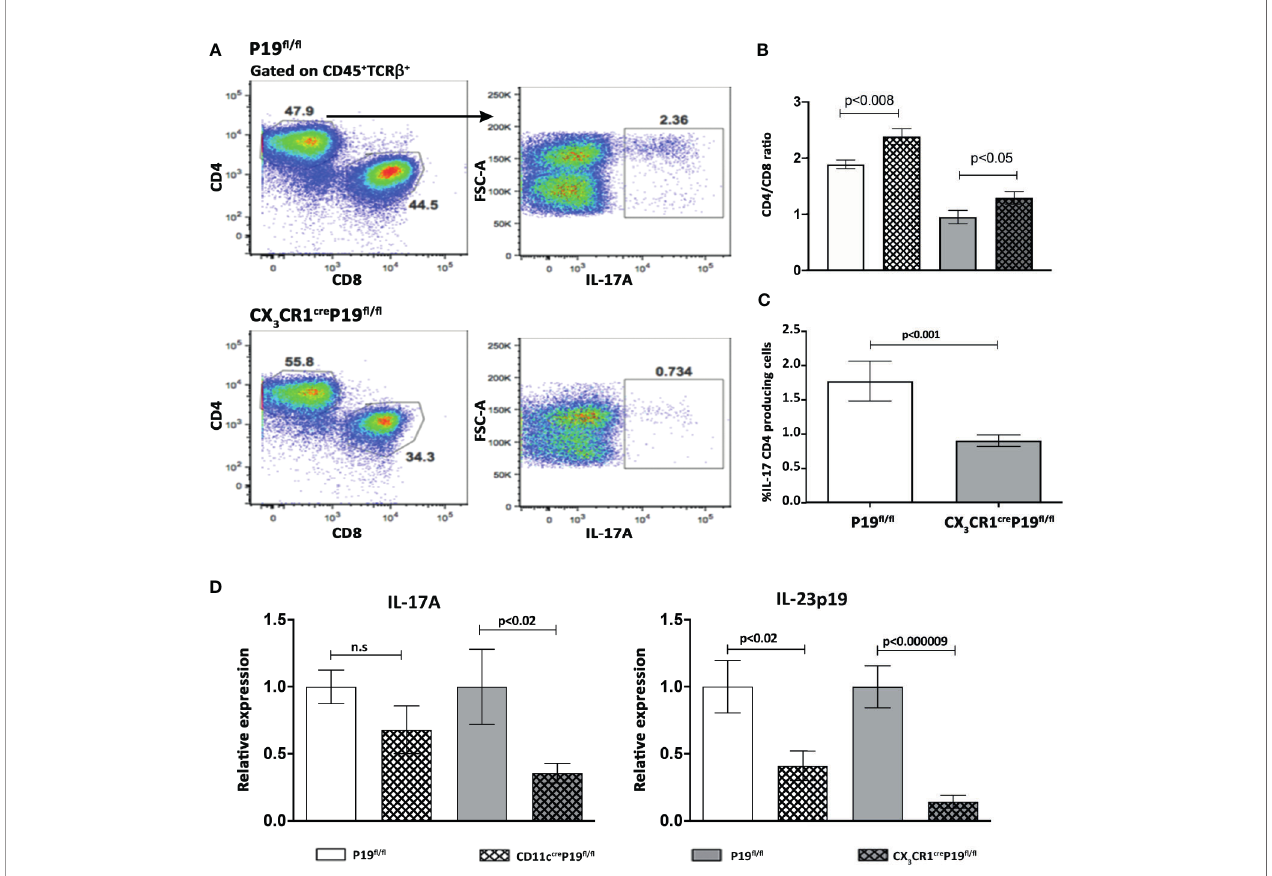
FIGURE 4 | MNPs restricted IL-23 de fi cient mice display a signi fi cant diminished activity of the IL-23-IL17 axis in the liver. (A) Flow cytometry analyses of puri fi ed non-parenchymal liver cells from indicated groups of mice, 8 weeks following 2OA-BSA immunization. (B) Graphical summary of the percentages of CD4/CD8 T cells ratio from CD11c cre P19 fl / fl and CX 3 CR1 cre P19 fl / fl immunized mice compared to their littermates ’ controls. (C) Graphical summary of the percentages of IL-17 CD4 + producing cells in CX 3 CR1 cre P19 fl / fl immunized mice vs. P19 fl / fl littermate controls. (D) Relative expression of hepatic IL-17A and IL-23p19 assessed by qPCR from indicated groups of mice, 8 weeks following 2OA-BSA immunization. Results presented as mean ± SEM (n ≥ 10) for each group. Results are representative of two independent experiments p values < 0.05 were considered as signi fi cant (unpaired Student ’ s